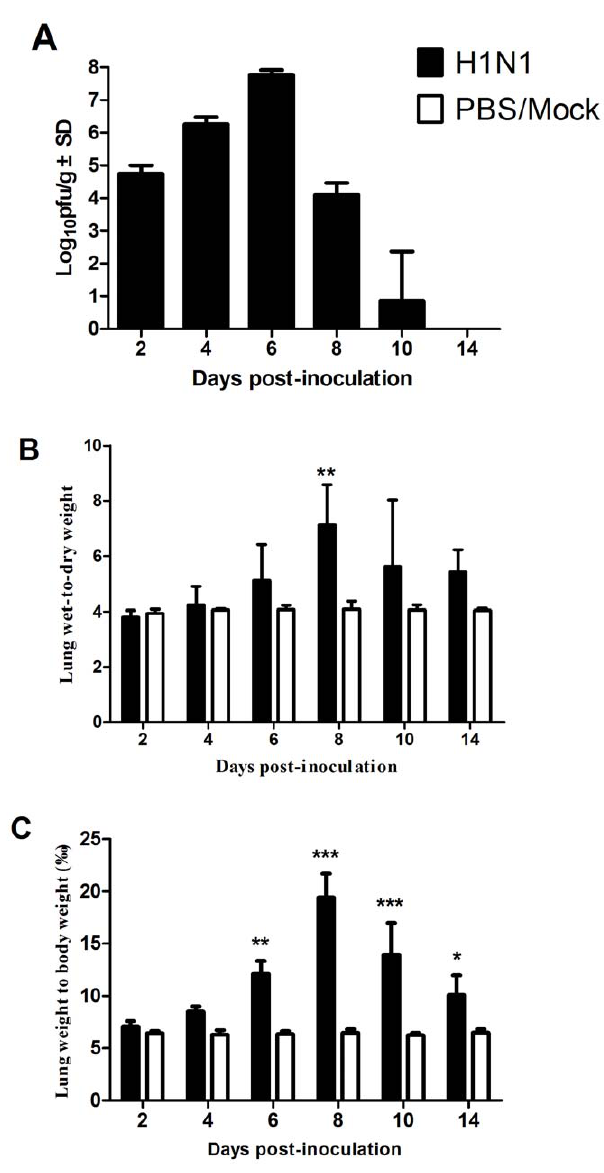
Figure 1. Virus titers in lung (A), wet:dry weight ratio (B) and wet weight:body weight ratios (C) of SD/09-infected mice. Mice were inoculated i.n. with 10 2.5 pfu SD/09 viruses; tissues were collected at indicated times p.i. and viruses were titrated in MDCK cells. Body weight, lung wet and dry weight were determined and recorded. The lung wet weight:body weight ratio and lung wet:dry weight ratio were calculated and used as an indicator of lung edema. *p , 0.05, **p , 0.01, ***p , 0.001, comparison between ratios obtained from the virus- infected and control groups. Bars represent means 6 SD of data from three